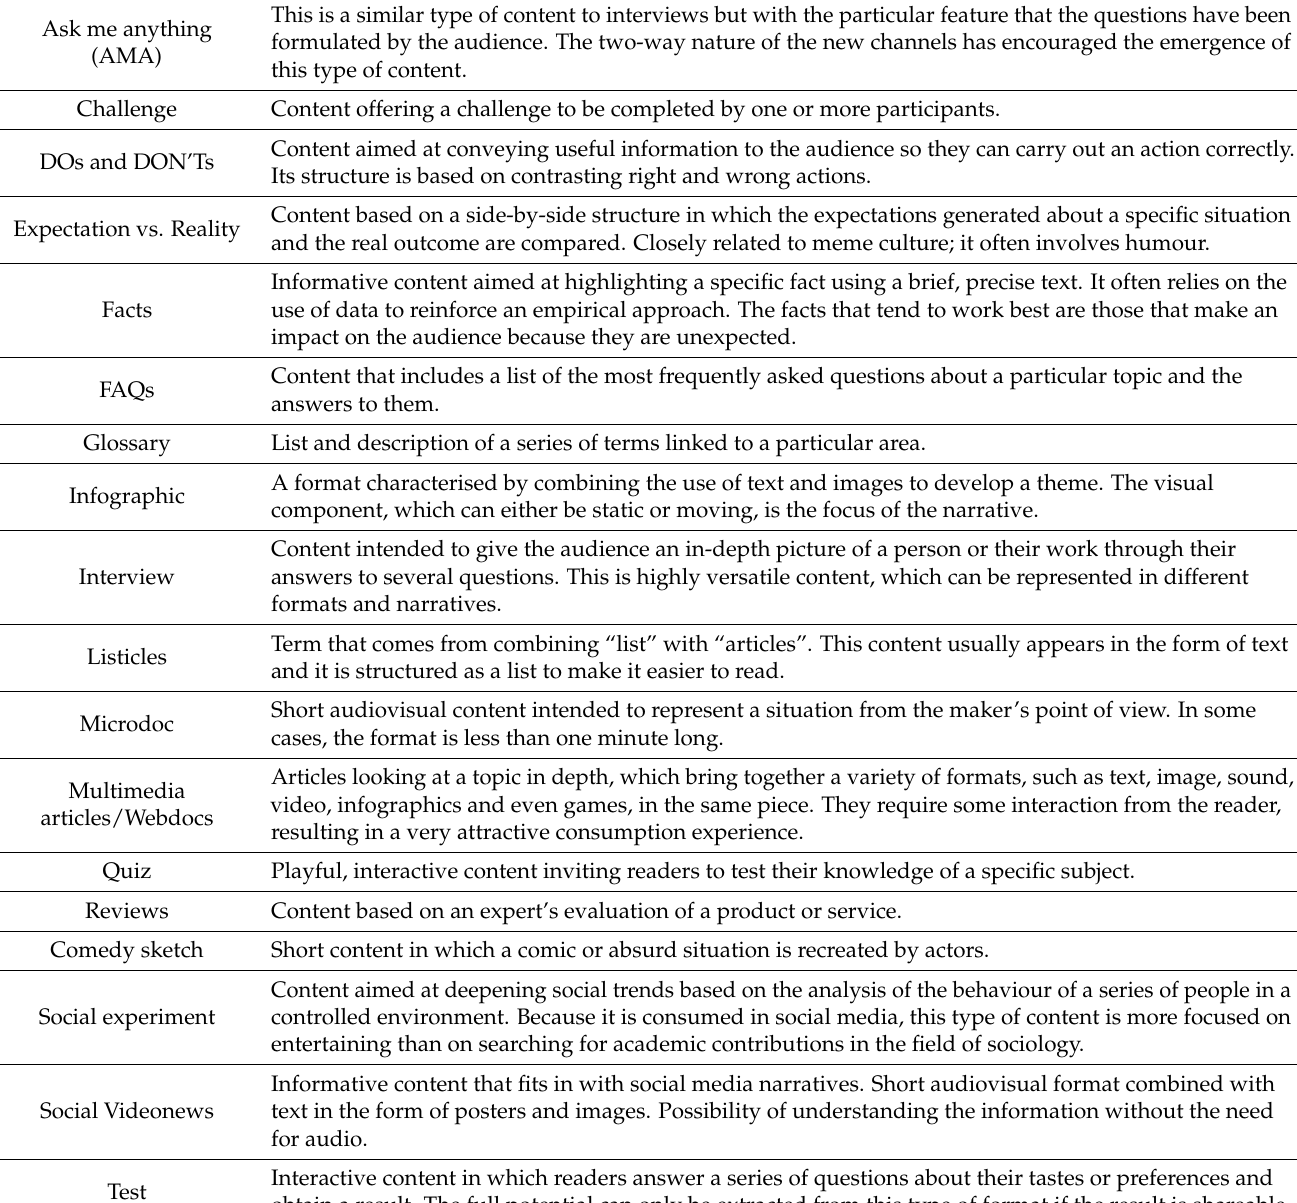
Table 1. Terminology used in the media to refer to the different formats and types of content used for editorial content and native